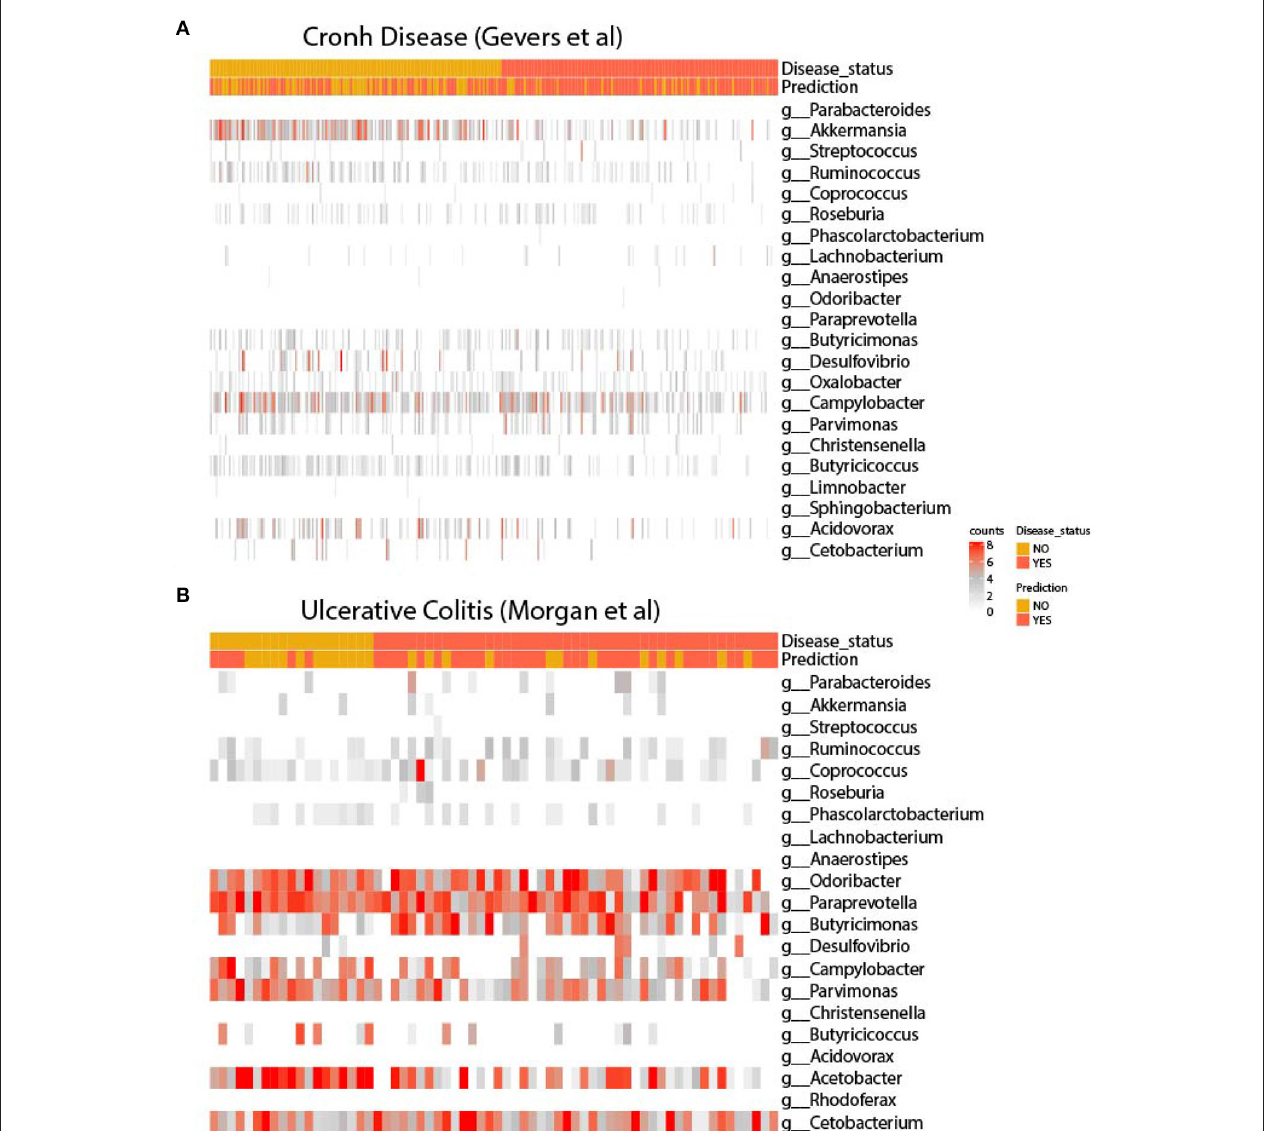
FIGURE 3 | Heatmaps of the signature in external cohorts. Abundance of genera used for retraining in the cohort of (A) Gevers et al. and (B) Morgan et al. In both figures, genera are ordered according to model importance.